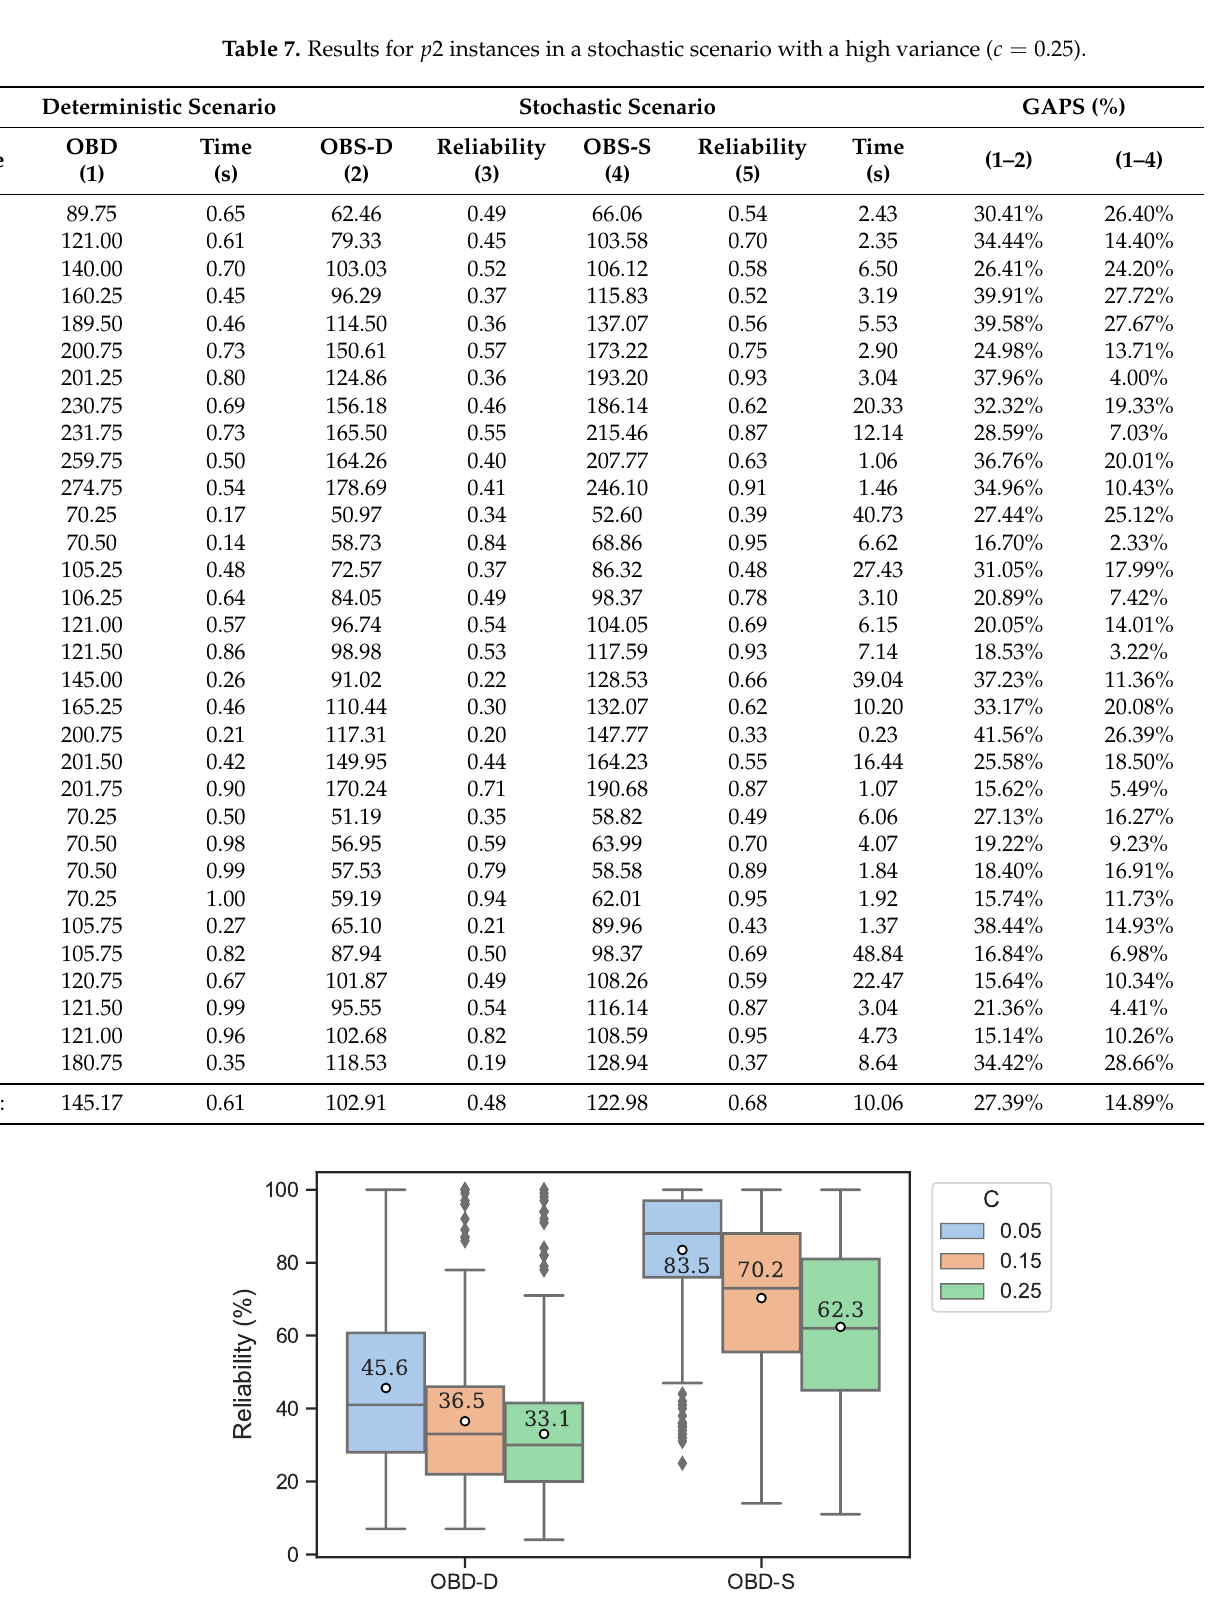
Figure 3. Comparison between the reliability of the stochastic